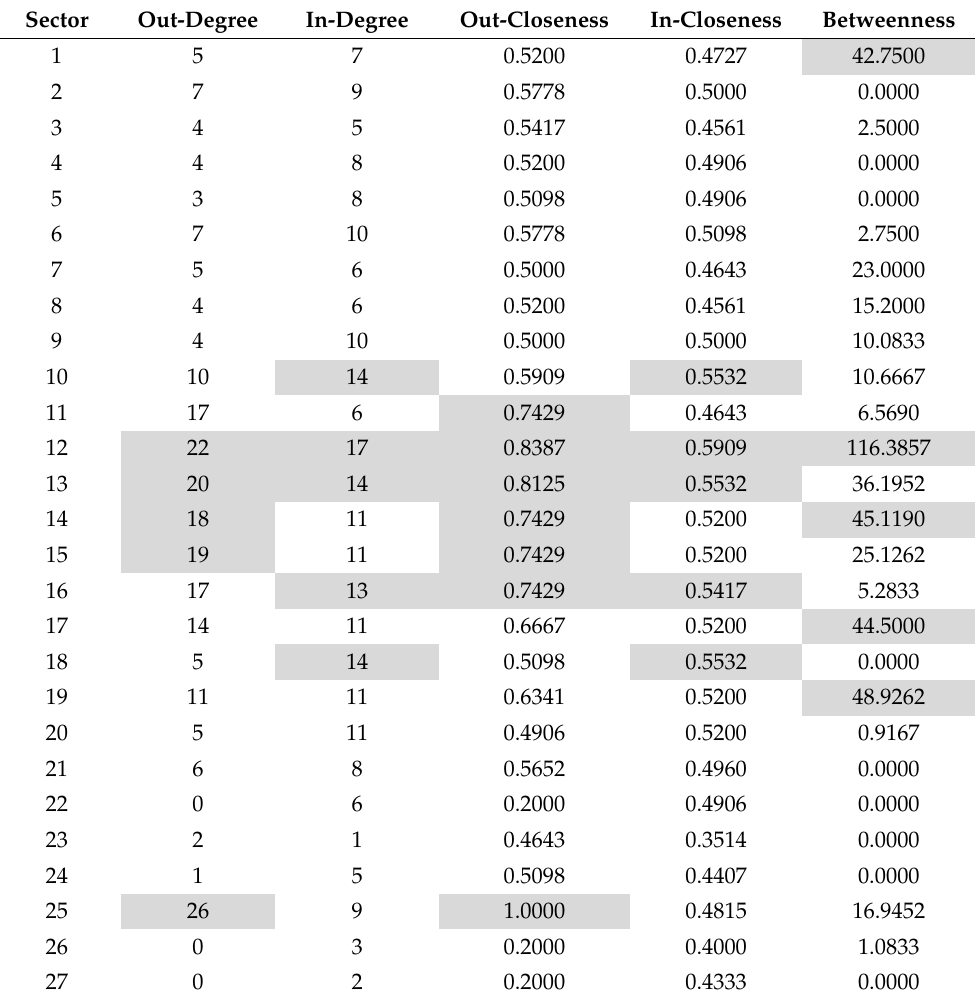
Table 7. The degree, closeness and betweenness of NO x metabolic